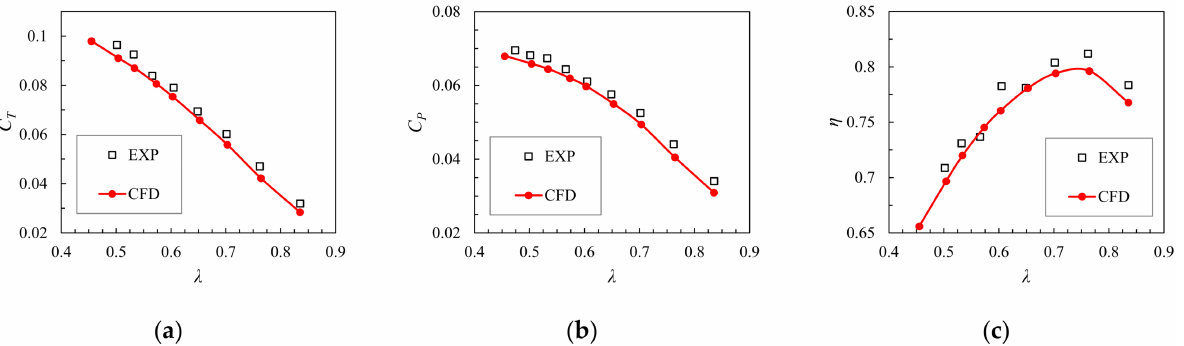
Figure 8. Experimental data and CFD results at an altitude of 10 km: ( a ) Thrust coefficient vs. advance ratio; ( b ) Power coefficient vs. advance ratio; ( c ) Propeller efficiency vs. advance